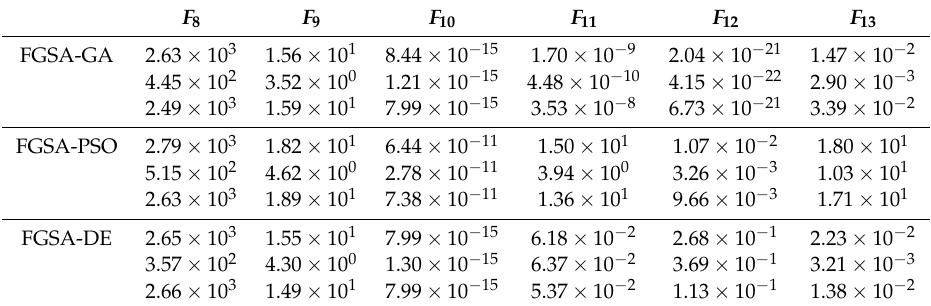
Table 6. Comparisons between FGSA-GA, FGSA-PSO and FGSA-DE over 16 runs for multimodal